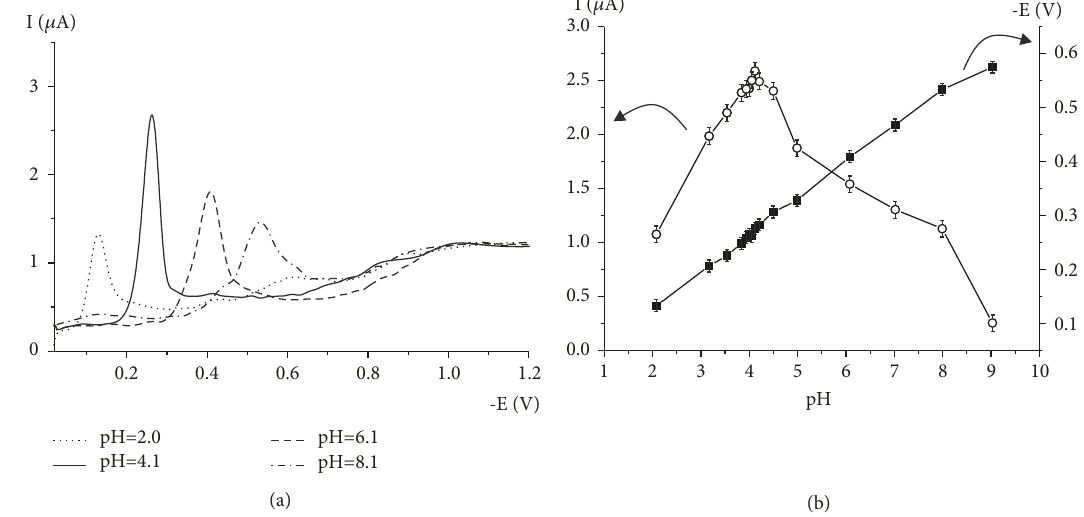
Figure 4: Polarogramms j C (a) and polarographic characteristics of derivatives at different pH (b) using phosphate buffer, C BC = 5 ⋅ 10 −5 mol ⋅ L −1 , C PMS = 10 −4 mol ⋅ L −1 , C buffer =0.2 mol ⋅ L −1 , duration of oxidation 10 min., and T= 60 ∘ b